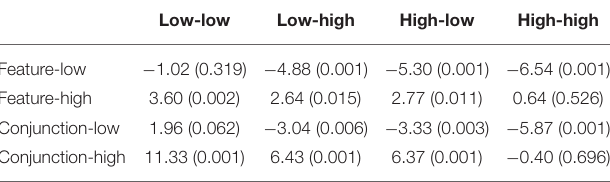
FIGURE 2 | Mean response times (ms) for control and test conditions. Whiskers indicate one standard deviation. TABLE 1 | Response time contrasts of control (row labels) vs. test (column labels) trial conditions: t -scores ( p